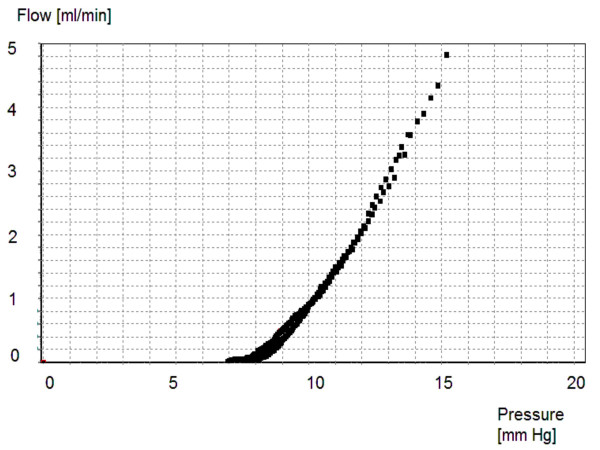
Individual pressure-flow curves for the Polaris Valve without a distal catheter and set at 70 mmH2O (5.2 mmHg).